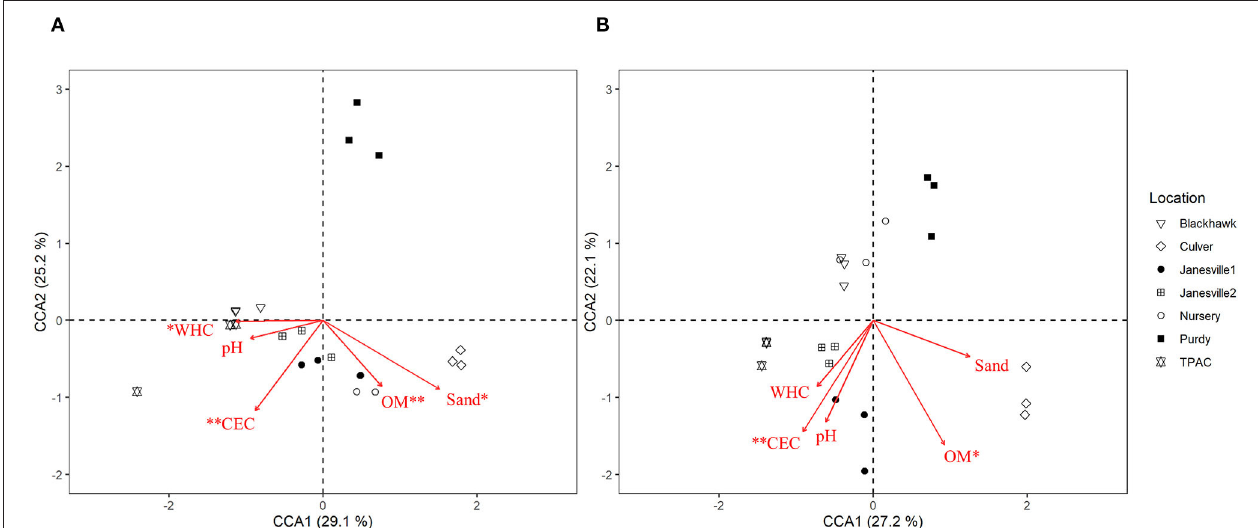
FIGURE 6 | Canonical correspondence analysis (CCA) calculated based on a Chi-square dissimilarity matrix of prokaryotic communities at the ASV rank in the midgut (A) and hindgut (B) of third instar Japanese beetle ( P. japonica ) larvae and host soil physicochemical parameters. Vectors show soil variables: cation exchange capacity (CEC), % organic matter (OM), pH, % sand (Sand), and water holding capacity (WHC). Significant soil variables are presented with two ( p ≤ 0.01) or one ( p ≤ 0.05) asterisks.